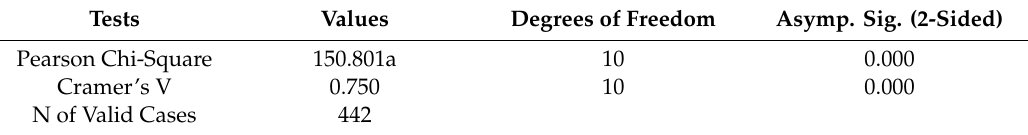
Table 2. Test statistics of house ownership and health